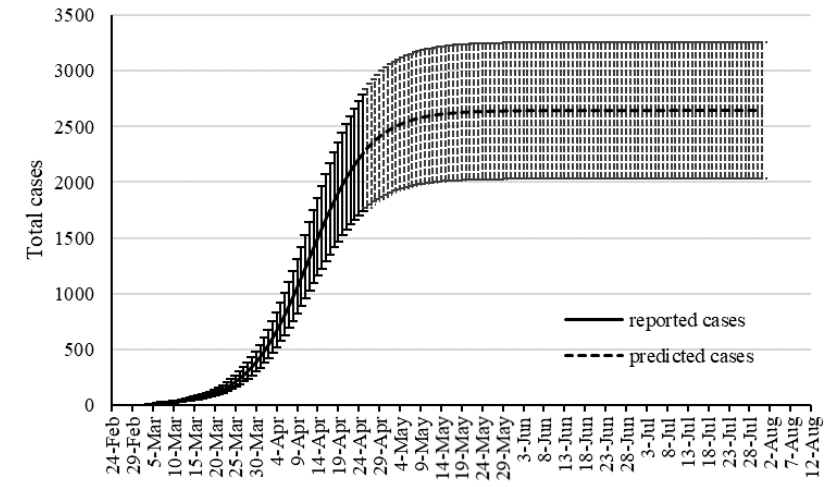
Figure 7. Deviation from target value (mortality rate).